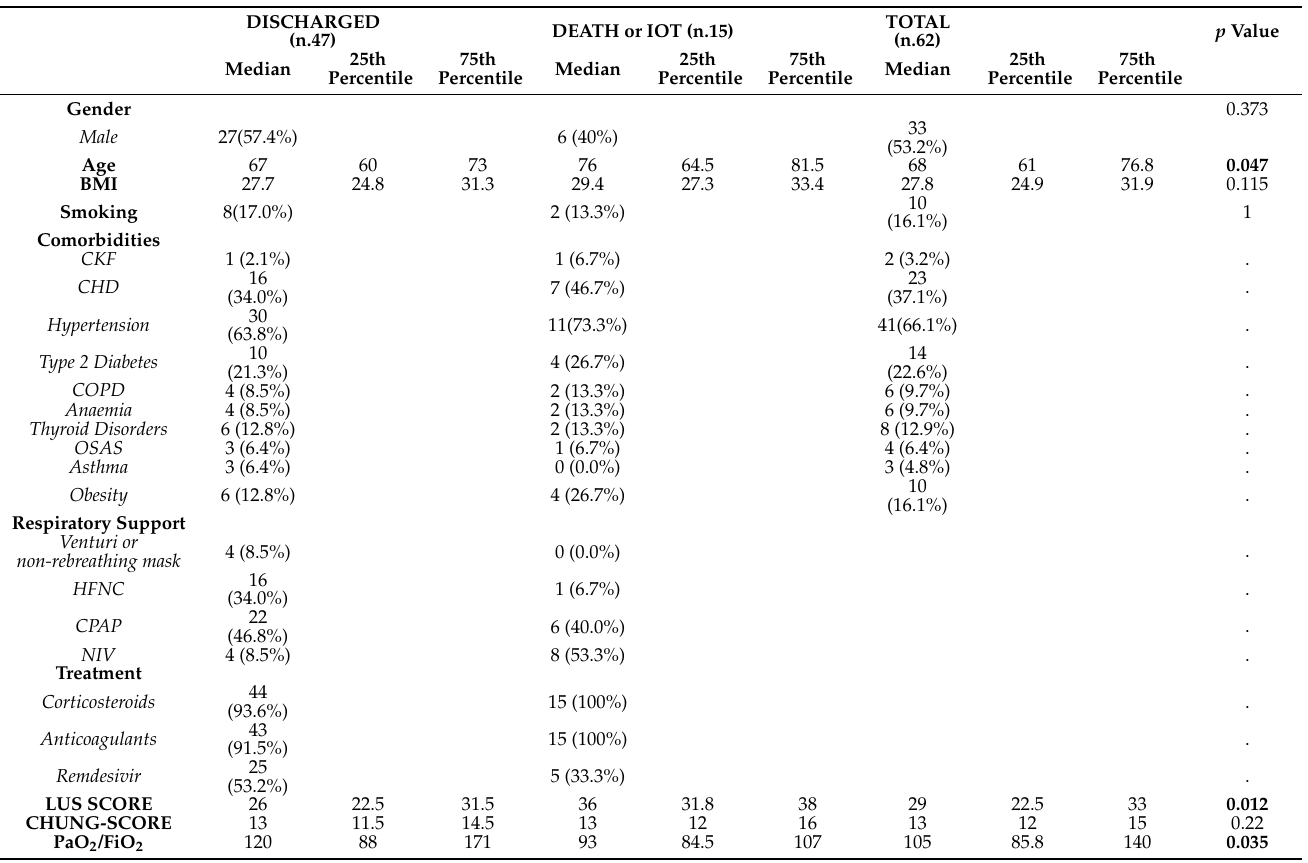
Table 1. Comparison of main anthropometrical and clinical parameters in discharged (n.47) vs. death or IOT (n.15) COVID-19 patients. Data are expressed as median value and interquartile range (IQR) or as absolute number and